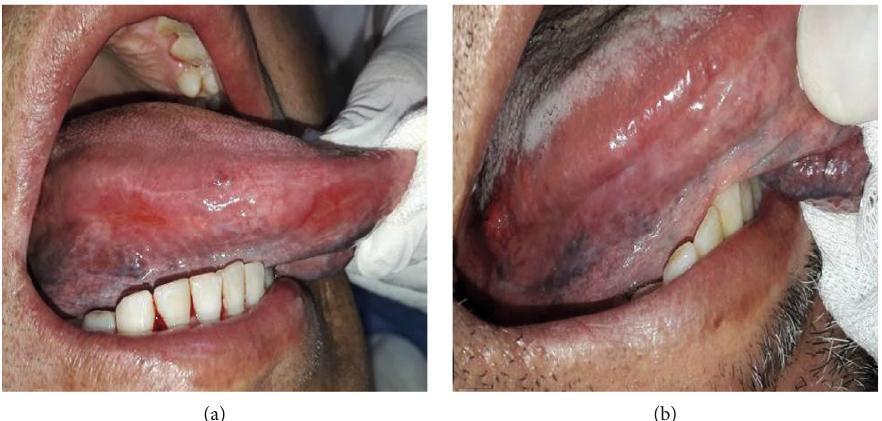
Figure 4: Intraoral view: right lateral edge and ventral side of the tongue in di ff erent stages of the treatment. (a) Two painful erosive ulcerations. (b) Improvement of the lesions and disappearance of the ulcerations. We notice the presence of a discrete reticular pattern that characterizes oral lichen planus.